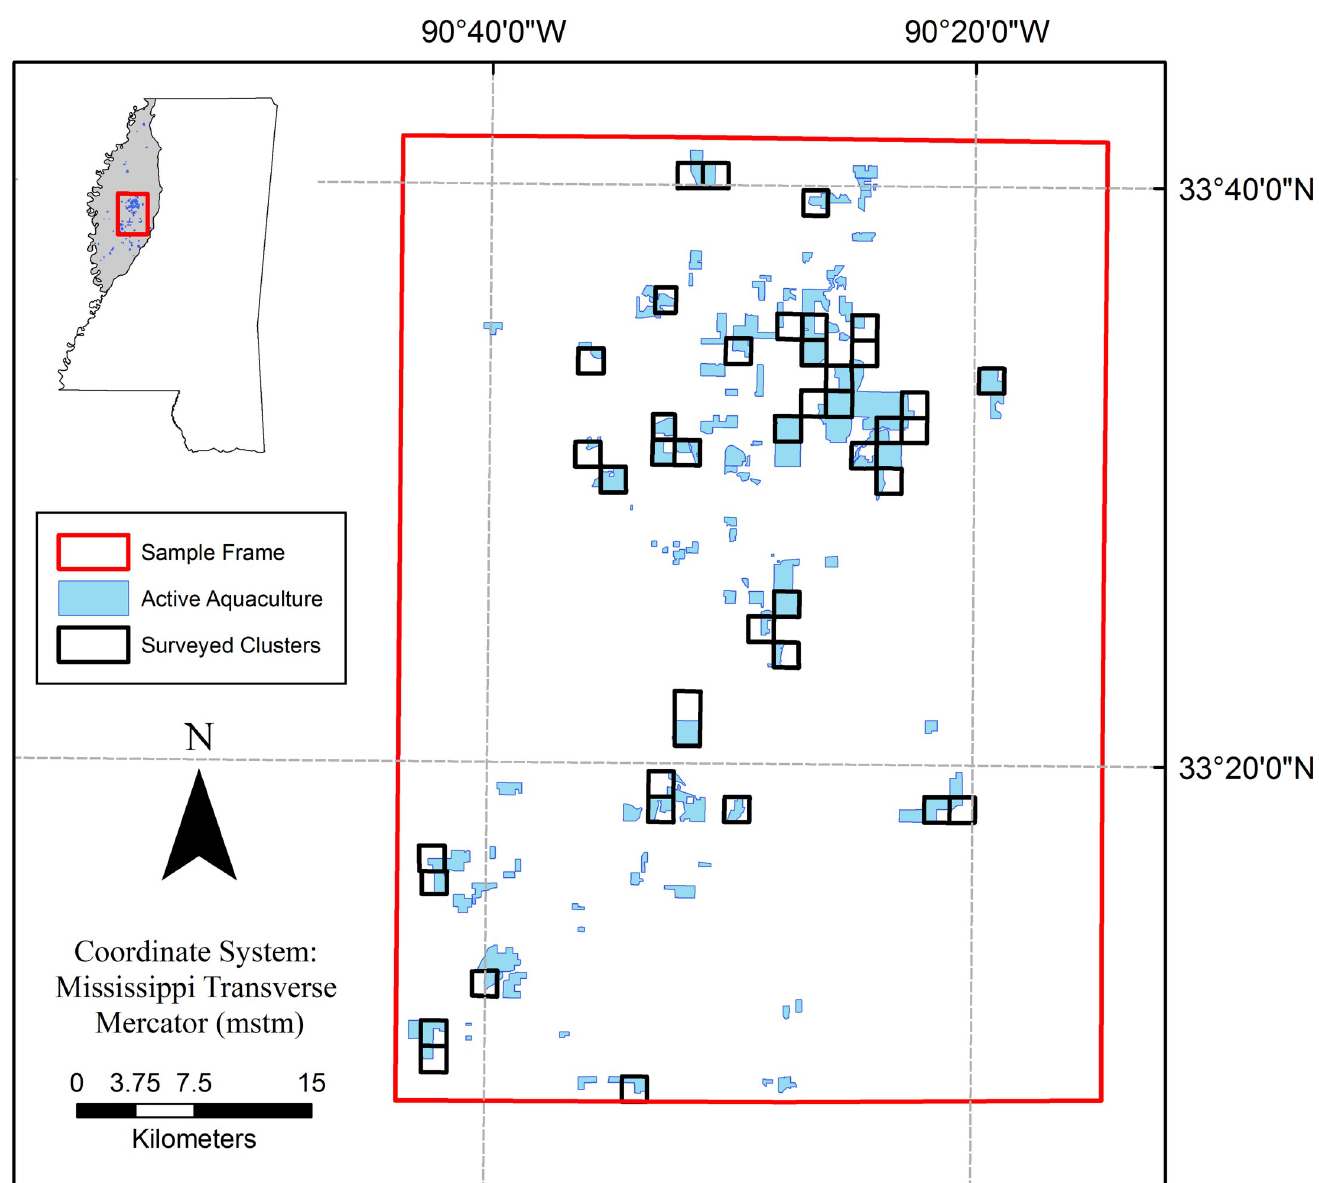
Fig 1. Sample frame established in the Mississippi Delta. Blue polygons represent aquaculture present during the study and black boxes within the sample frame represent aquaculture clusters randomly selected for surveys. Aerial surveys were conducted on these selected clusters to collect presence data of double-crested cormorants ( Phalacrocorax auritus ), great egrets ( Ardea alba ), and great blue herons ( A . herodias ). A total of 35 surveys were completed over the months of October through April of three years, 2015–2017.